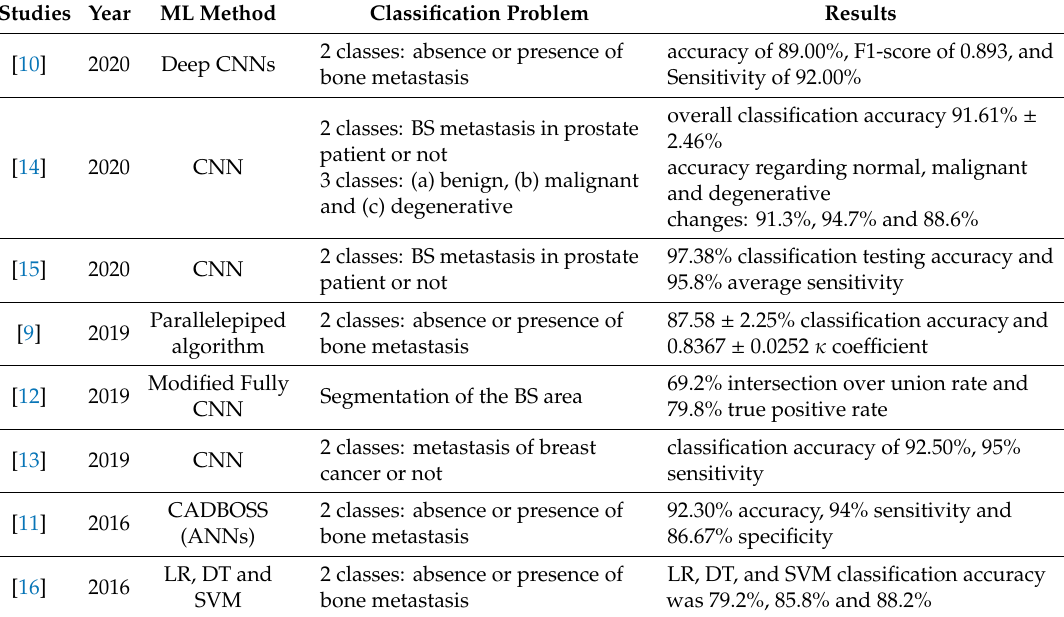
Table 7. Summarized results of state-of-the-art ML approaches for bone metastasis (BS)